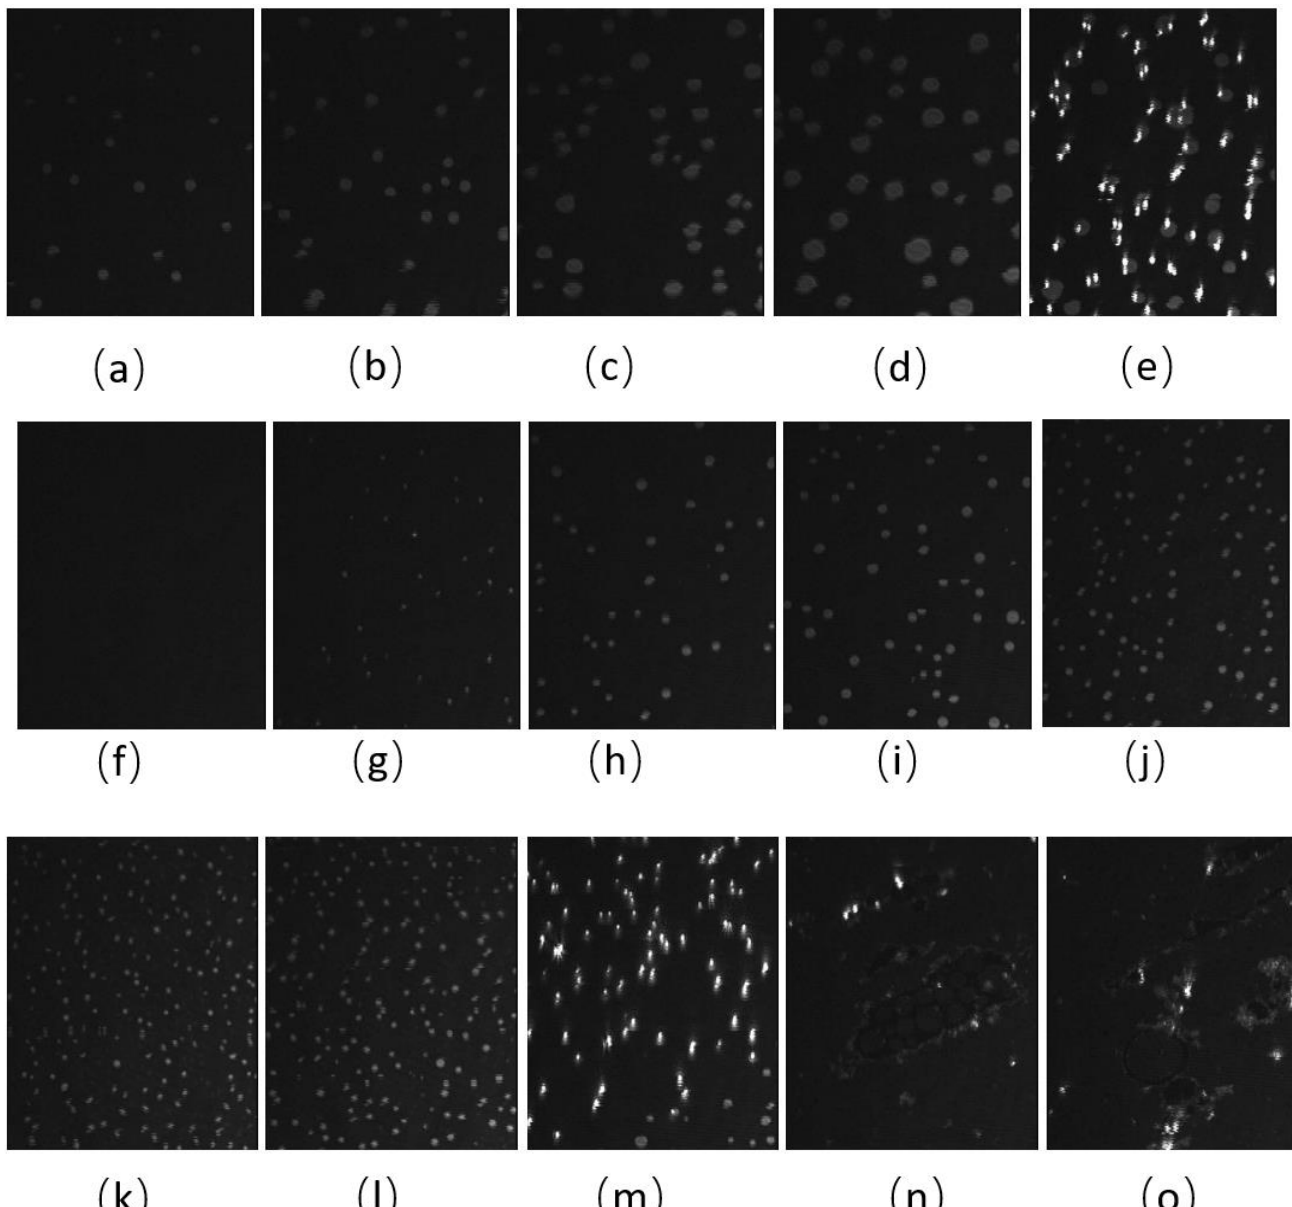
Figure 4. ( a – j ) BAM images (220 µ m wide) of CO:GT:PC 40:40:20 (ternary mixture) film before ozone exposure ( a – e ) and after ozone exposure ( f – j ) at surface pressures of 7 mNm − 1 , 9 mNm − 1 , 12 mNm − 1 , 14 mNm − 1 and, 17 mNm − 1 on PBS at 22 ◦ C. ( k , l ) BAM images (220 µ m wide) of CO:GT:PC 40:40:20 (ternary mixture) film at surface pressures of 18 mNm − 1 and 20 mNm − 1 after ozone exposure on PBS at 22 ◦ C. ( m – o ) BAM images of CO:GT:PC 40:40:20 (ternary mixture) film at surface pressures (left to right) of 18 mNm − 1 , 16 mNm − 1 , 15 mNm − 1 after ozone exposure, taken after the end of film